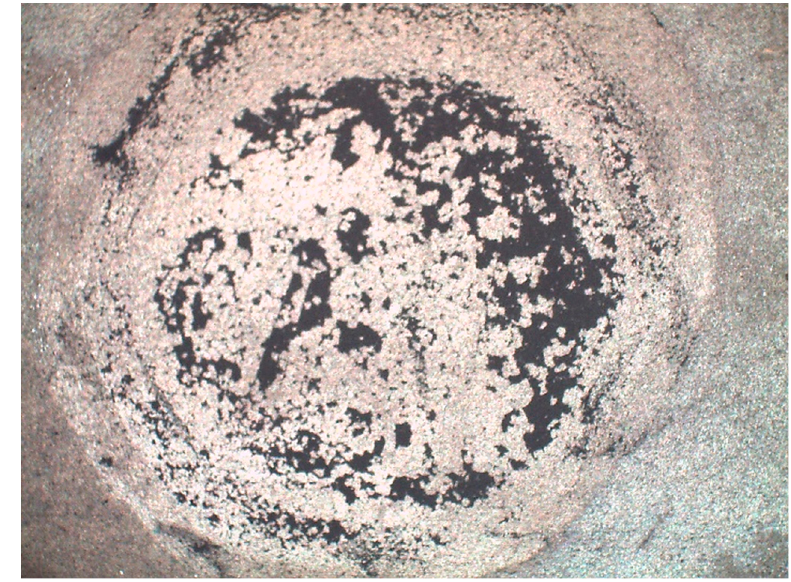
Figure 9. Top view of pulled-off area of an Ni-P plated PHNBR sample at 40 °C for 60 min.